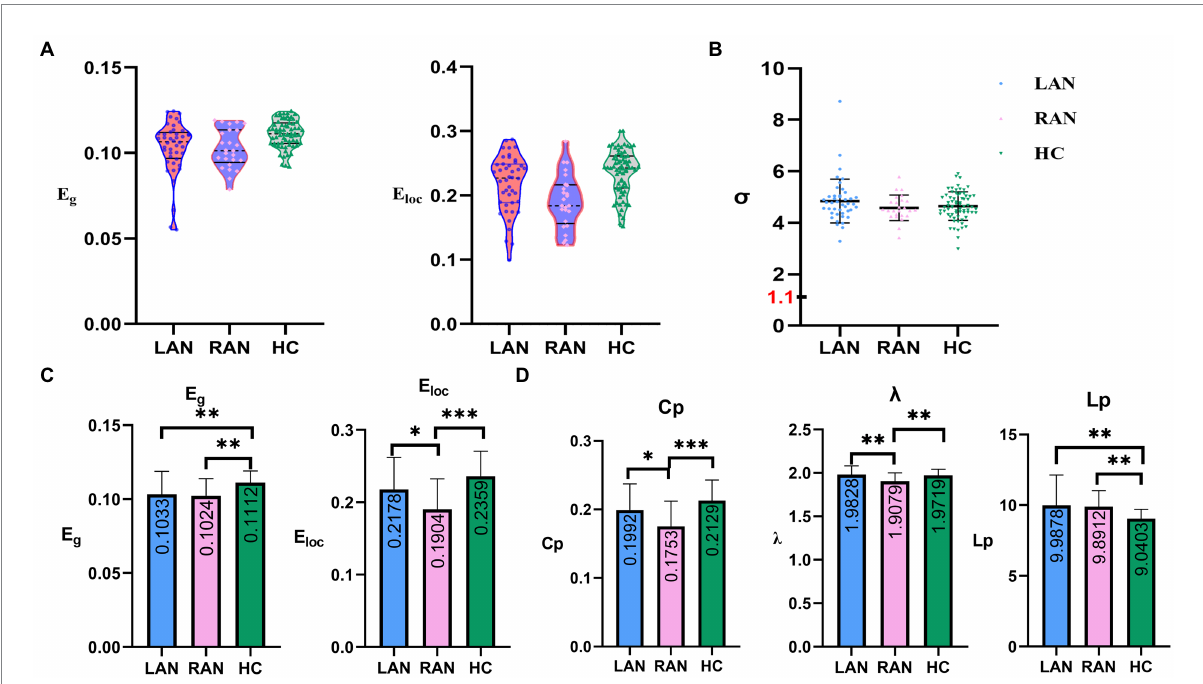
FIGURE 2 The comparisons of global metrics in three groups. (A) Scatter plots representing the distribution of global efficiency (E g ) and local efficiency (E loc ) in LAN, RAN, and HC groups. (B) Scatter plots representing the distribution of small world properties ( σ ) in the LAN, RAN, and HC groups. (C) E g and E loc of structural brain network for three groups. E g and E loc in AN patients decreased compared to the HC group. (D) Shortest path length (Lp), clustering coefficient (Cp), and small-world parameters λ ( λ = Lp real / Lp random, Lp real : the Lp of the real network; Lp random : the Lp of random network) of structural brain network for three groups. The numbers in the box represent mean values. Error bars represent mean ± standard